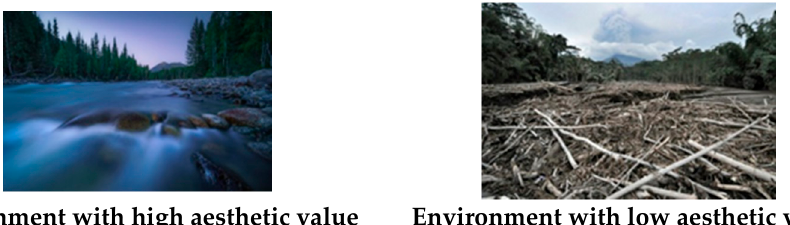
Figure 2. Examples of the environmental photographs as a priming stimulus in Experiment 1a.